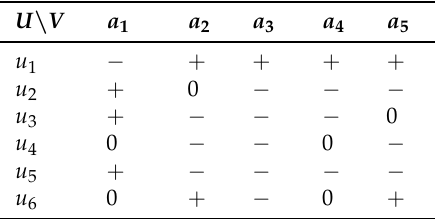
Table 1. Information system for the Middle East